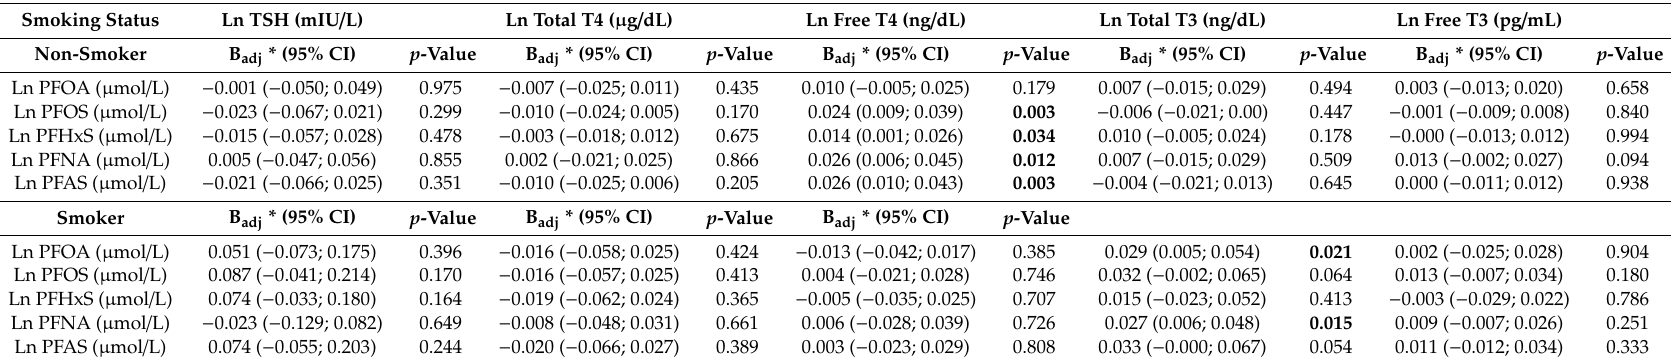
Table 3. Stratified weighted adjusted * analysis model estimates for the association between PFAS and thyroid hormones in smokers and non-smokers ( n =